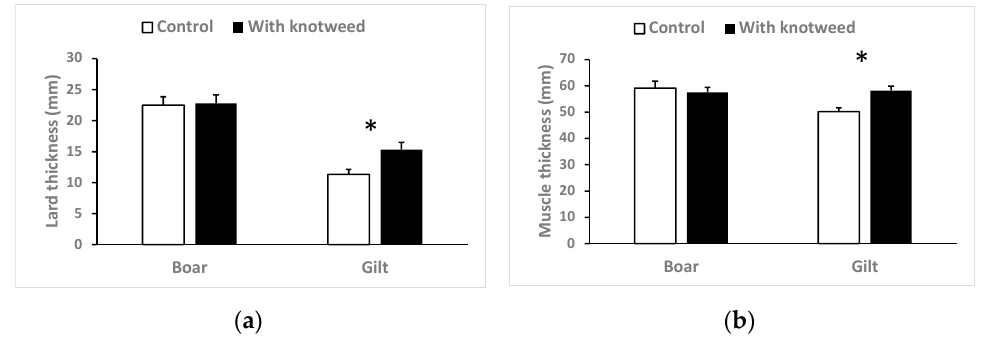
Figure 4. The average thickness of lard ( a ) and muscle ( b ) measured at slaughter using the ZP method in pigs fed on a feeding mixture with knotweed addition compared to pigs fed on a standard feeding mixture, separated according to sex. Means + SEM. Difference significant on p < 0.05 marked by an asterisk.